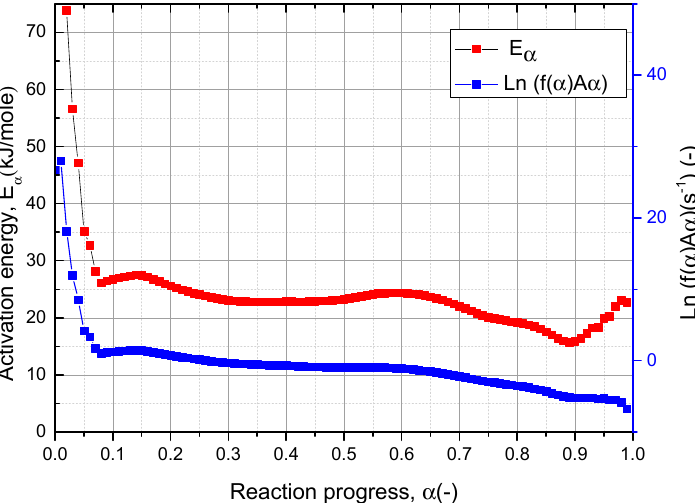
Figure 6. Activation energy and modified reaction constant ( A α f( α ) ) of reaction steps 1 and 2 denoted in Figure 5b as a function of reaction progress α .